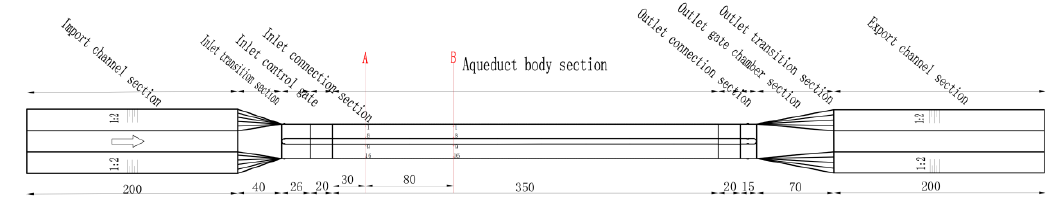
Figure 4. Layout of measuring points on a typical aqueduct.